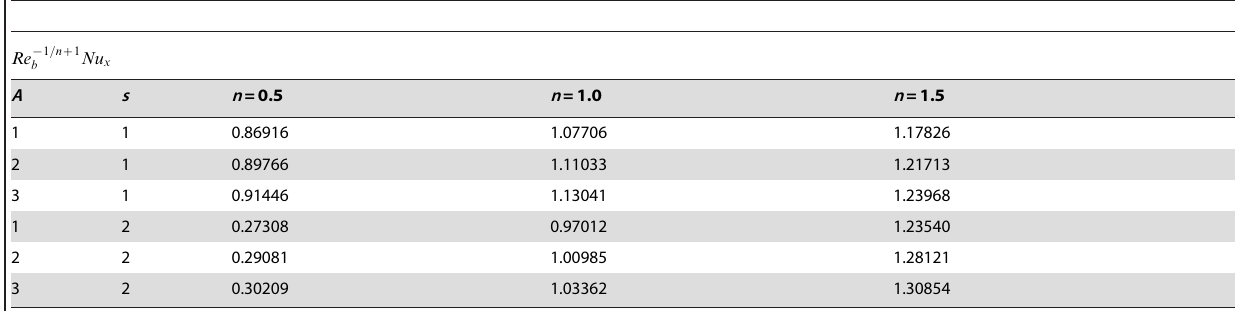
Table 2. The numerical values of the Local Nusselt number in the PHF case when m ~ 1 and Pr ~ 1 are fixed.